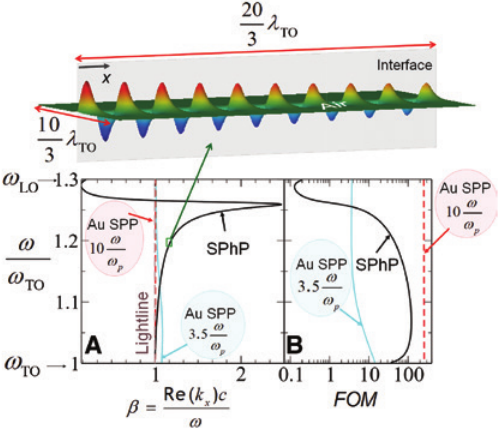
Figure 17: Surface phonon polaritons (SPhPs) at plane interfaces. (A) SPhP dispersion (black solid line) at the interface of air and the PhP medium of Figure 13. Re( k ) is represented with the x dimensionless parameter β after scaling its value with the free- space wave vector ω / c . The upper panel shows the x -component of the electric-field for the mode designated with the green rectangle. = 2 π c / ω (Note, λ .) The SPhP dispersion is compared with the SPP TO TO dispersion at an air-Au planar interface at two different frequency regions; around telecomm wavelengths (red-dashed line) and in the green-blue part of the visible spectrum (cyan line). (B) Figure of merit ( FOM ) [see Eq. (43)] for the SPhP mode (black-solid line) compared to the FOM s of the SPP mode at the two frequency regimes that were shown in